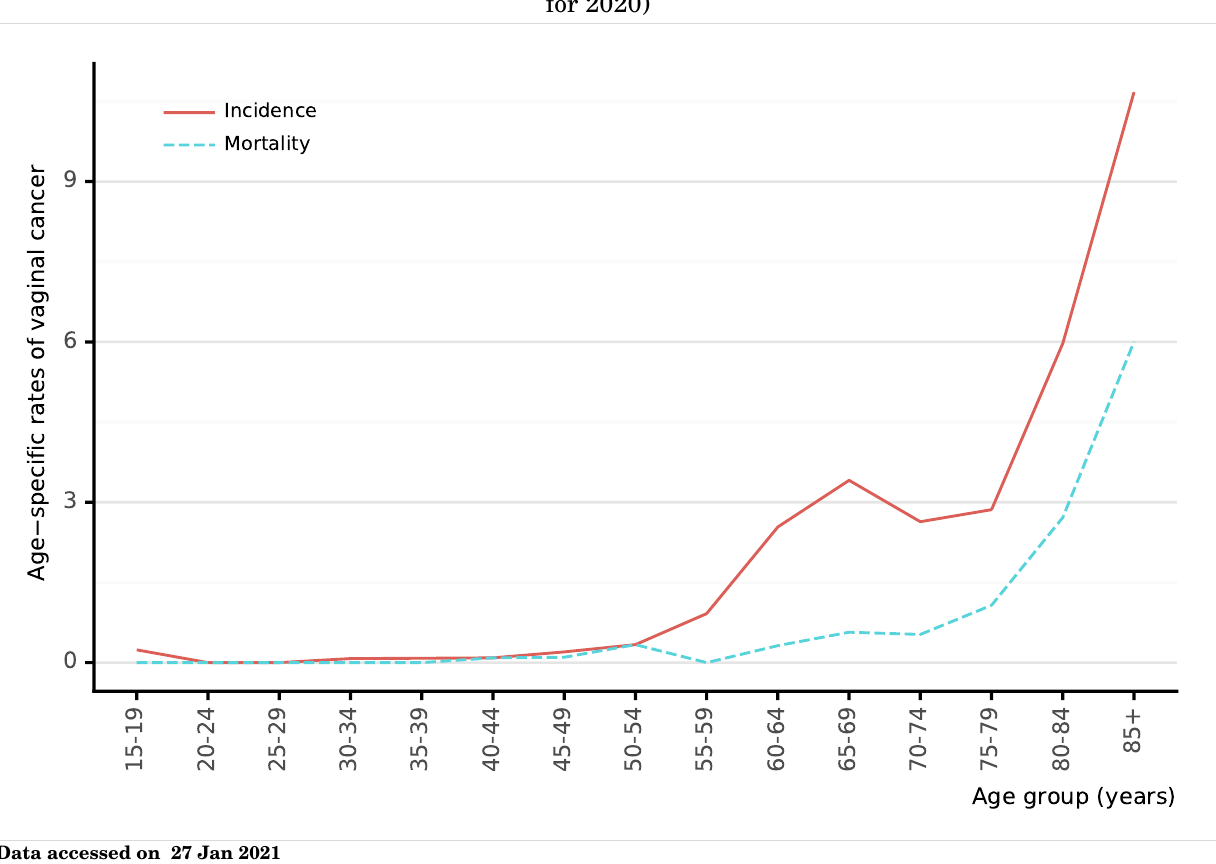
Figure 30: Comparison of age-specific vaginal cancer incidence and mortality rates in Peru